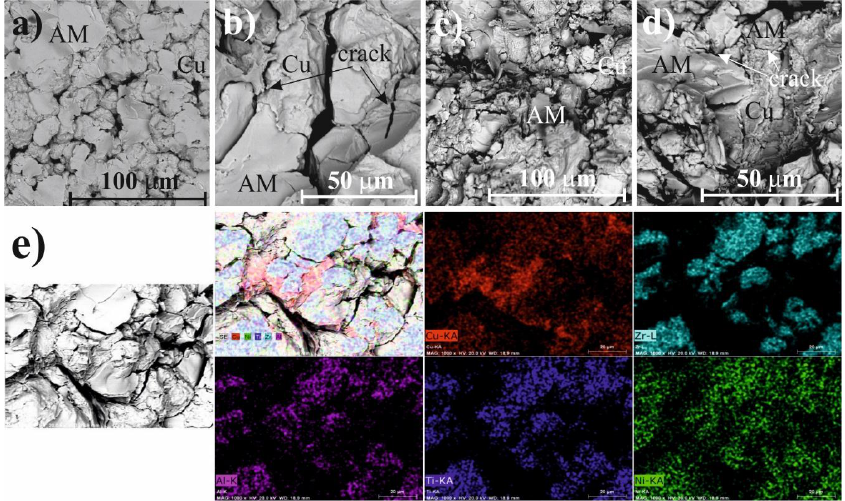
Figure 10. Fracture surface of the composites ( a , b ) BM6; ( c , d ) BM9 (AM: amorphous powder, Cu: copper powder); ( e ) BM6 EDS elemental map of the same area.